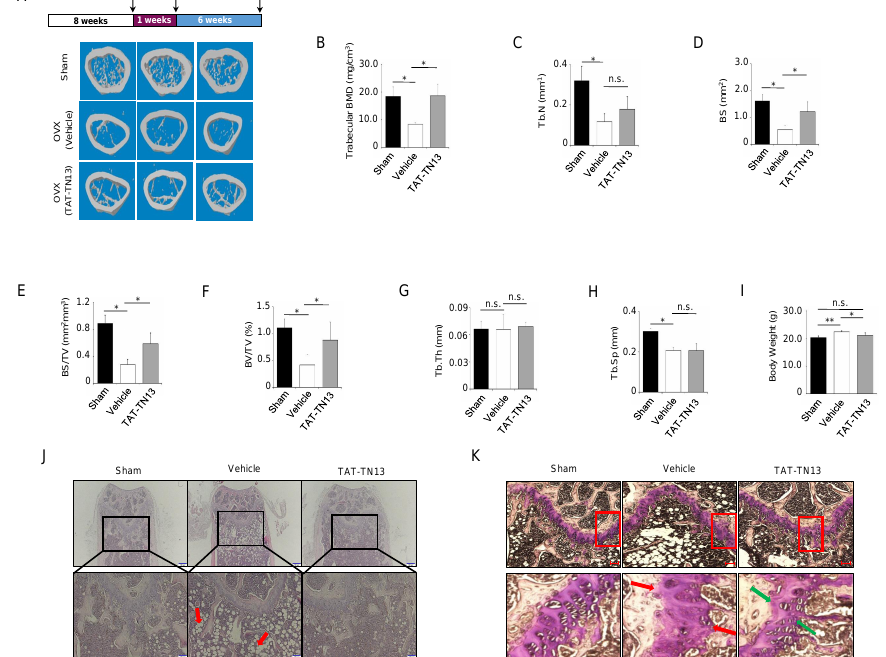
Figure 6. TAT-TN13 effectively prevents OVX-induced bone loss in vivo. ( A ) The fixed femurs were analysed by using micro-CT, and three-dimensional reconstructed images from each group are shown. ( B–H ) For each sample, bone mineral density (BMD), trabecular number (Tb.N), bone surface (BS), bone surface per total volume (BS/TV), bone volume per total volume (BV/TV), trabecular thickness (Tb.Th) and trabecular separation (Tb.Sp) were measured. ( I ) Body weight gain of OVX mice. The results are presented as the mean ± S.D of two independent experiments (* p < 0.05, ** p < 0.01 and *** p < 0.001; n.s.: not significant). ( J , K ) The femurs were fixed in 4%paraformaldehyde, decalcified, embedded, and sectioned as described in the Experimental section. Sections of femur were stained with H&E (magnification 10 × , 20 × , scale bars: 100 µ m) and TRAP (magnification 10 × , 40 × , scale bars: 100 µ m). Representative image was observed by using a microscope. These experiments were repeated 2 times ( n = 6/group). Red arrows in ( J ) indicate bone loss and areas of osteolysis in the vehicle-treated OVX group. Green arrows indicate decreased osteoclast surface in the TAT-TN13-treated OVX group and red arrows indicate increased osteoclast surface in the vehicle-treated OVX group in ( J